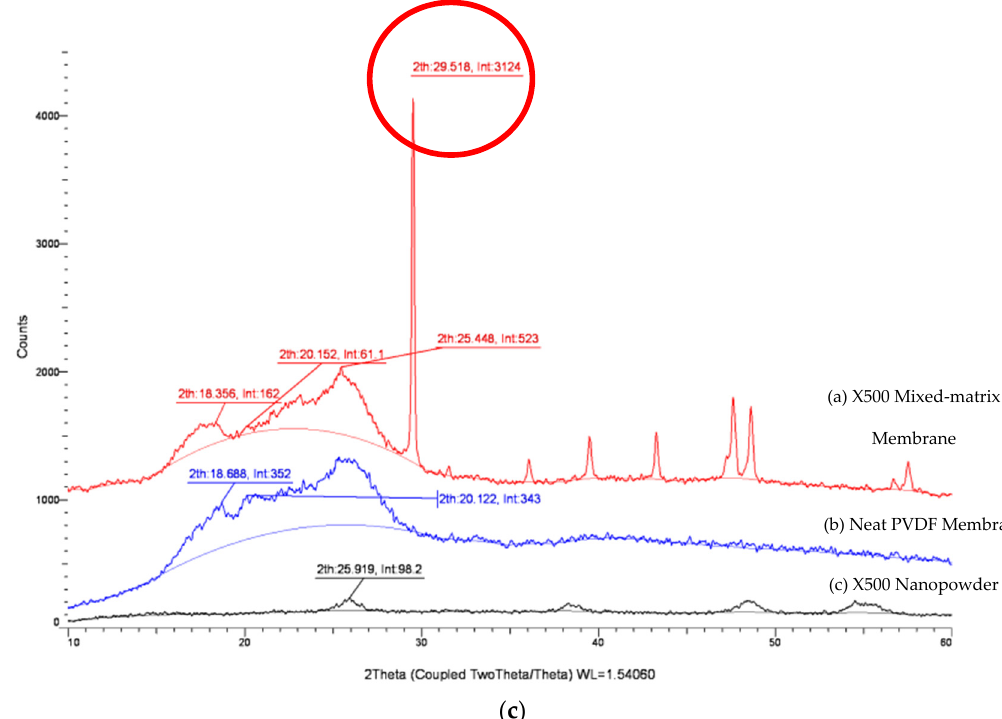
Figure 5. XRD patterns of PVDF/TiO 2 MMMs, neat PVDF membrane and TiO 2 nanopowder. ( a ) PC-20, ( b ) P25, ( c ) X500.